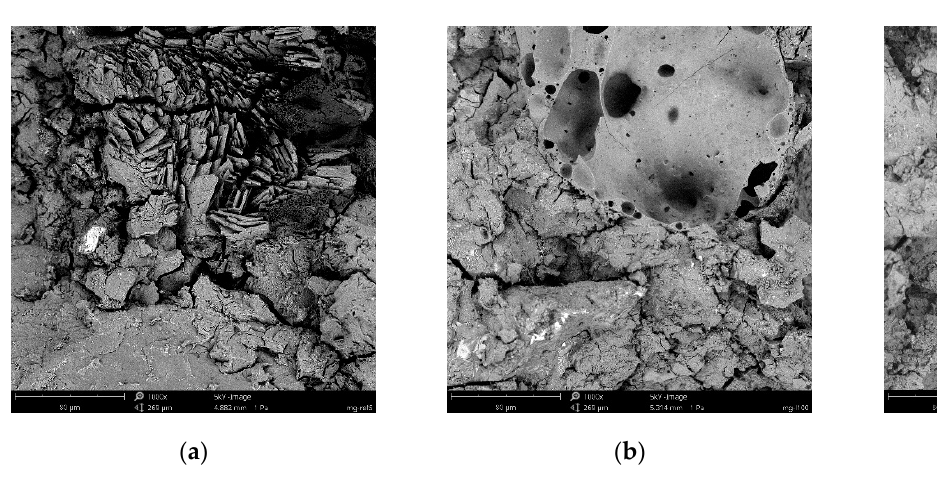
Figure 6. Microstructure of MKPC-based mortars gained by SEM, magnification 1000×. ( a ) MP-REF 5, various degrees of hydration; ( b ) MP-L, the transition between the magnesia-phosphate hydration product and expanded glass grain; ( c ) MP-R, non-compact hydrated structure around the rubber particle.